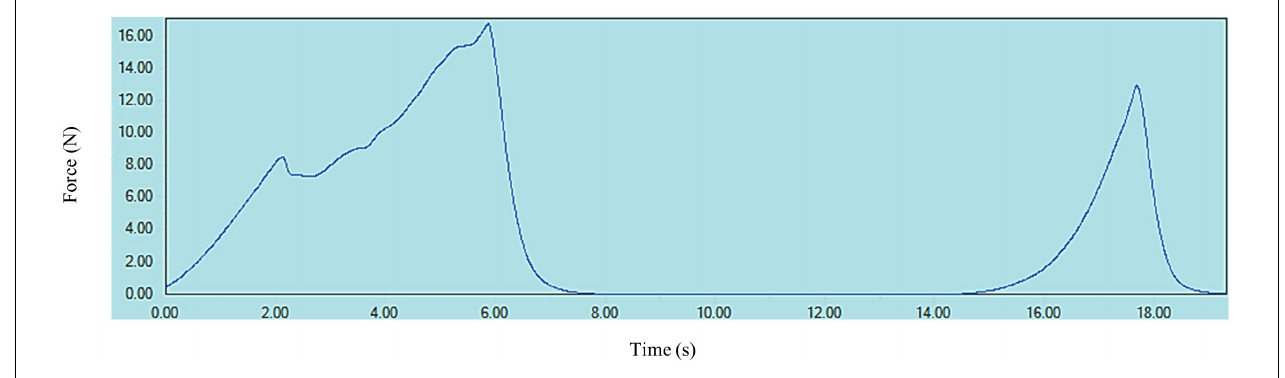
FIGURE 1 | A typical texture profile curve for cooked kabuli chickpeas.